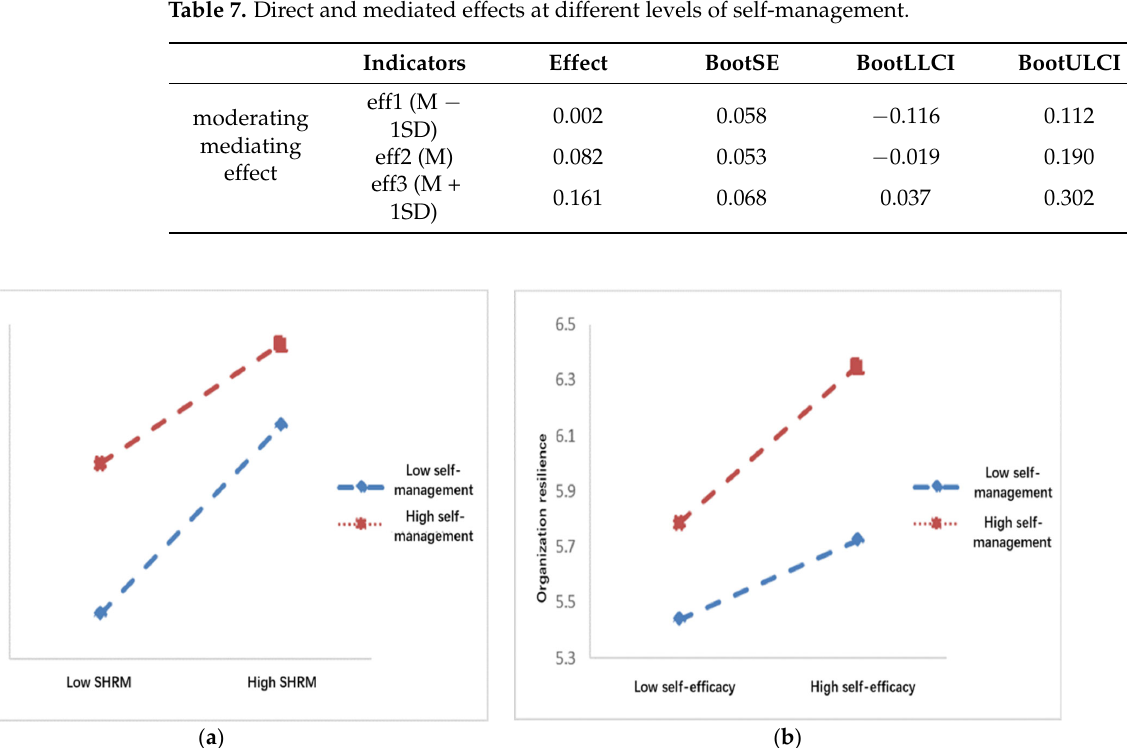
Figure 2. ( a ) The moderating role of self ‐ management in the relationship between strategic human resource management and organizational resilience; ( b ) the moderating role of self ‐ management in the relationship between self ‐ efficacy and organizational resilience. Table 6. Mediated model tests with moderation.